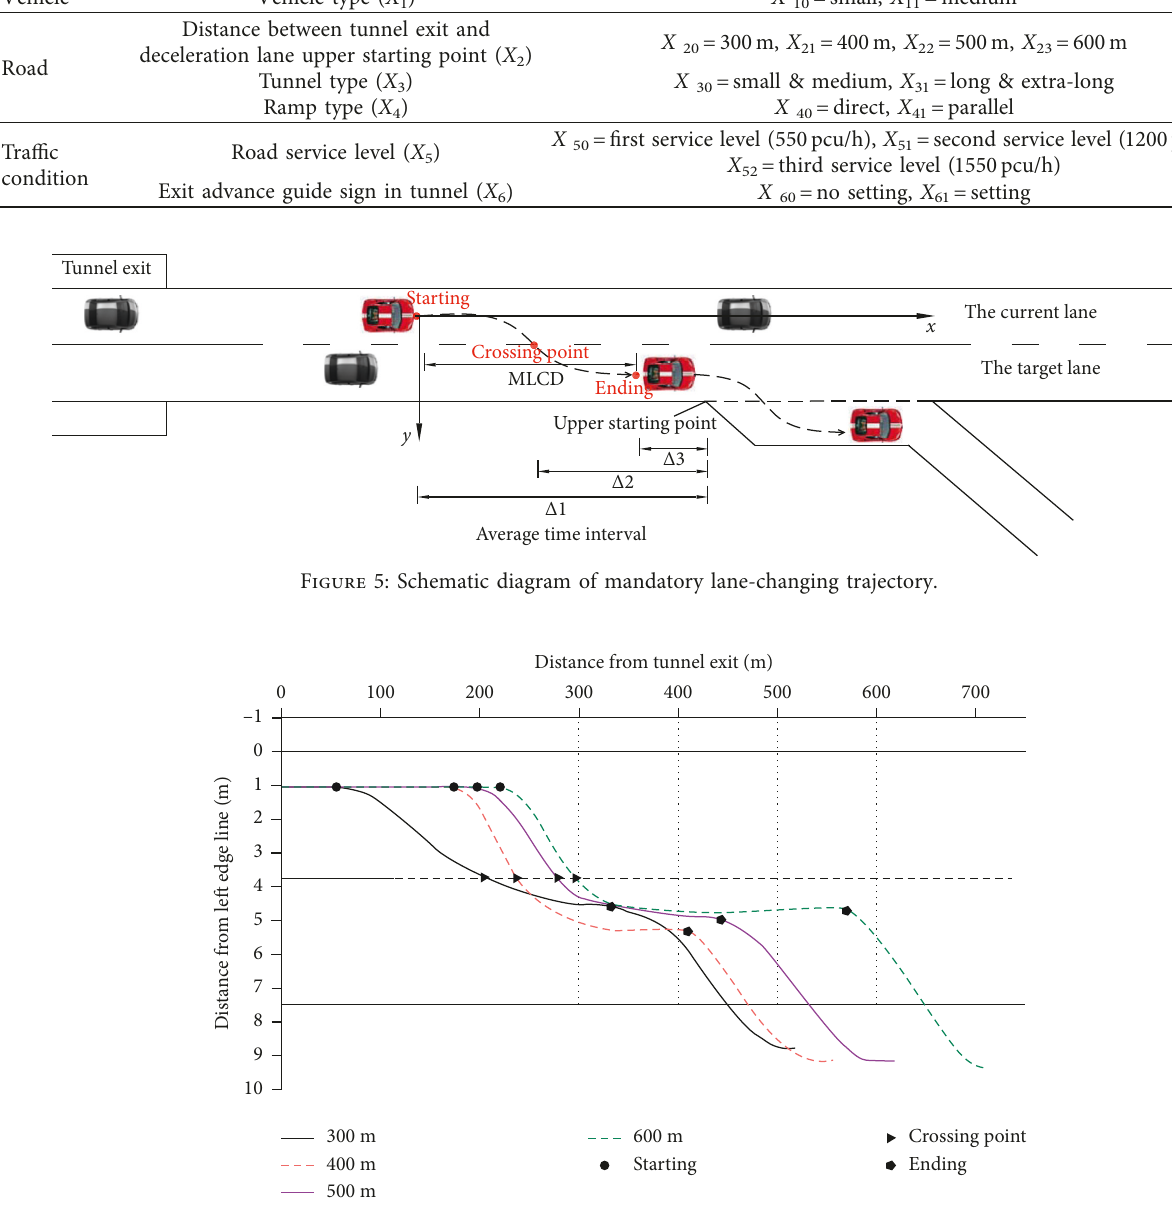
Figure 6: Mandatory lane-changing trajectory of different